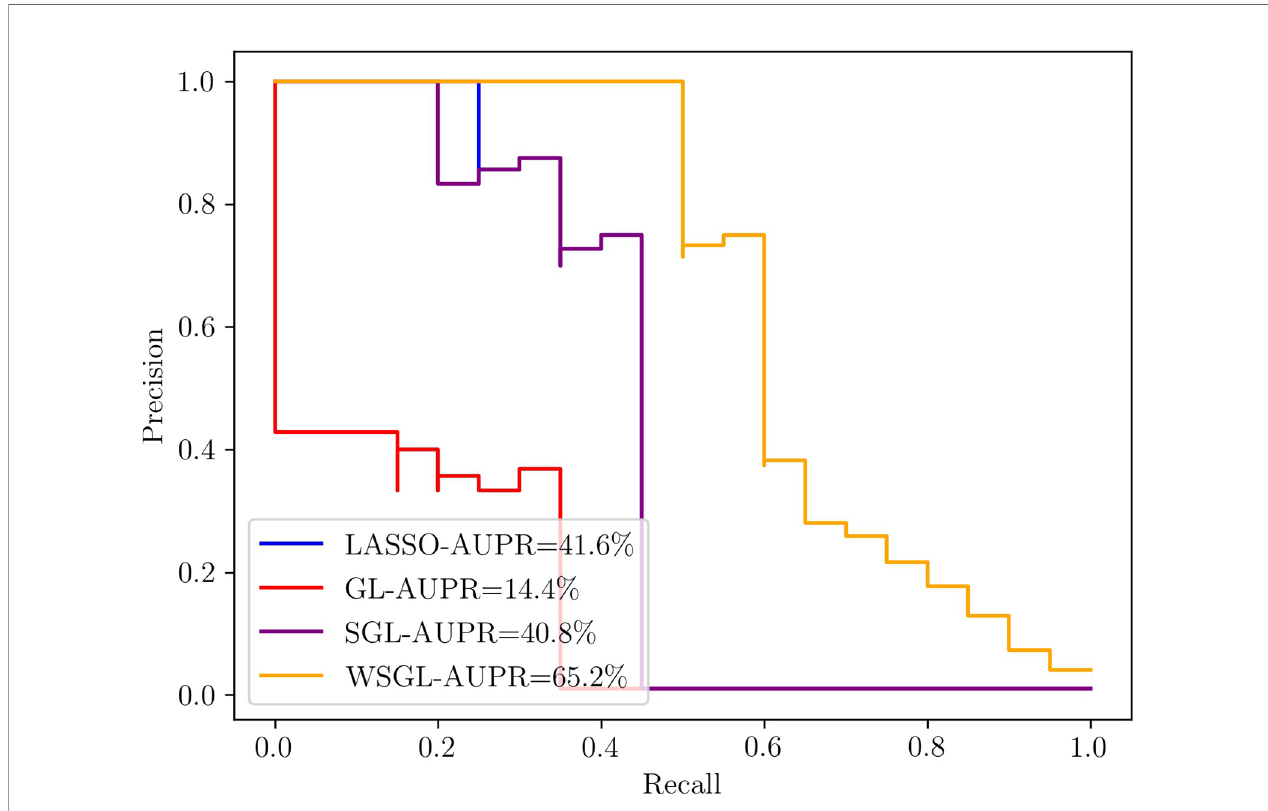
FIGURE 1 | Precision-recall (PR) curves of WSGL and the other